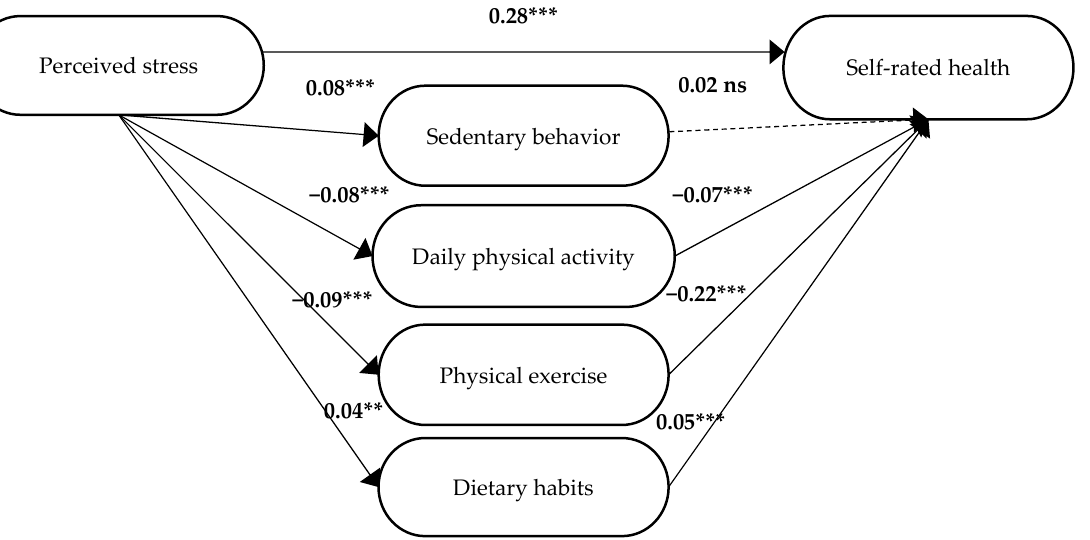
Figure 3. The first model for participants who did not report any of the requested diagnoses. The standardized beta coefficients ( β ) are included for the different paths between the independent variable, i.e., perceived stress, the mediators, i.e., sedentary behaviour, daily physical activity, physical exercise, and dietary habits, and the dependent variable, i.e., self-rated health. ** p ≤ 0.01, *** p ≤ 0.001.